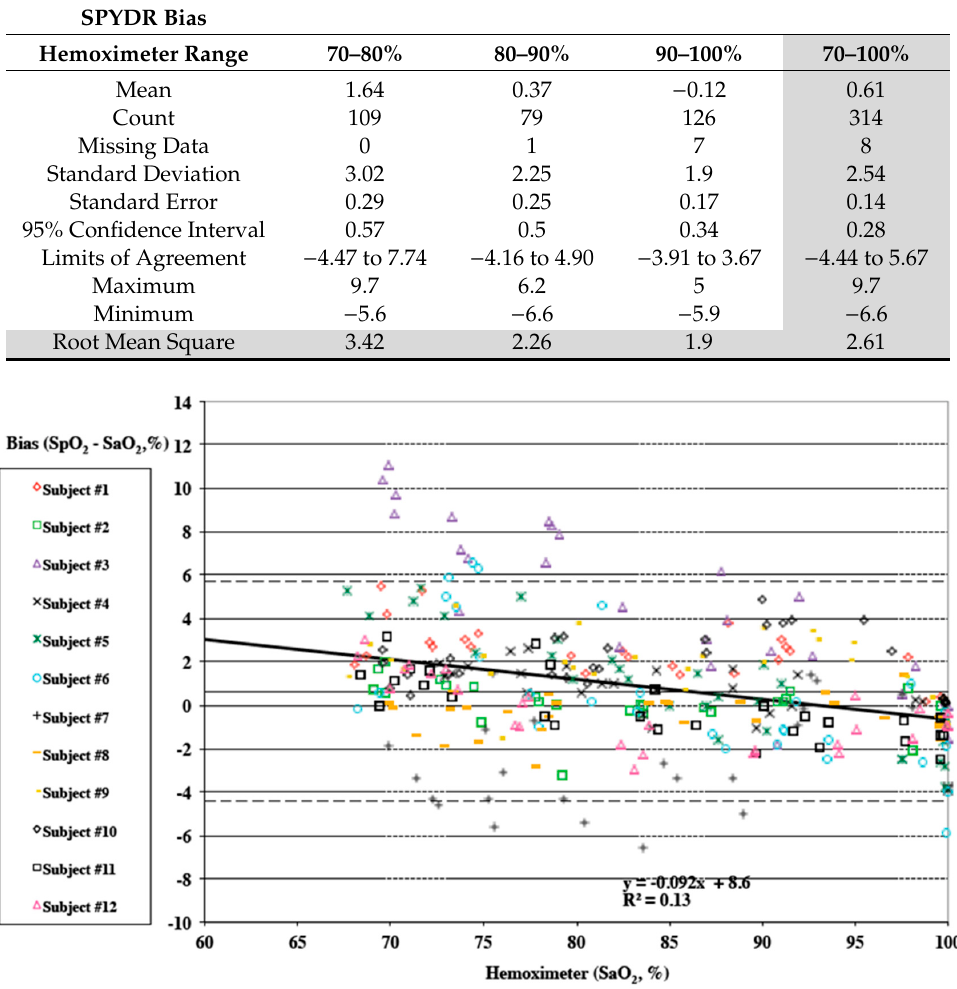
Figure 2. Bias plot of SpO 2 determined by SPYDR vs. SaO 2 determined by arterial blood gas analysis. A negative slop of the trendline suggests that, as commonly seen in reflectance oximetry, SpO 2 values were more accurate at higher true values of SaO 2 (e.g., clinically normal, 90–100%).